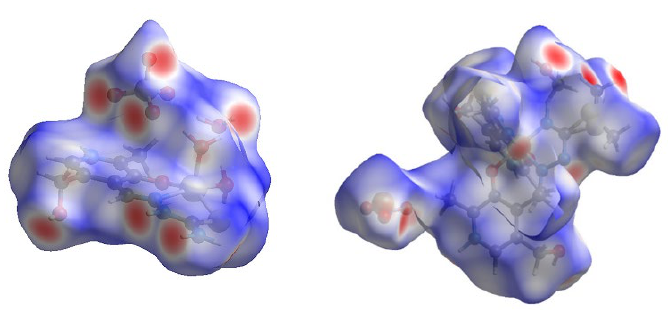
Figure 3. The Hirshfeld surfaces of compounds 2 (left) and 1 (right).